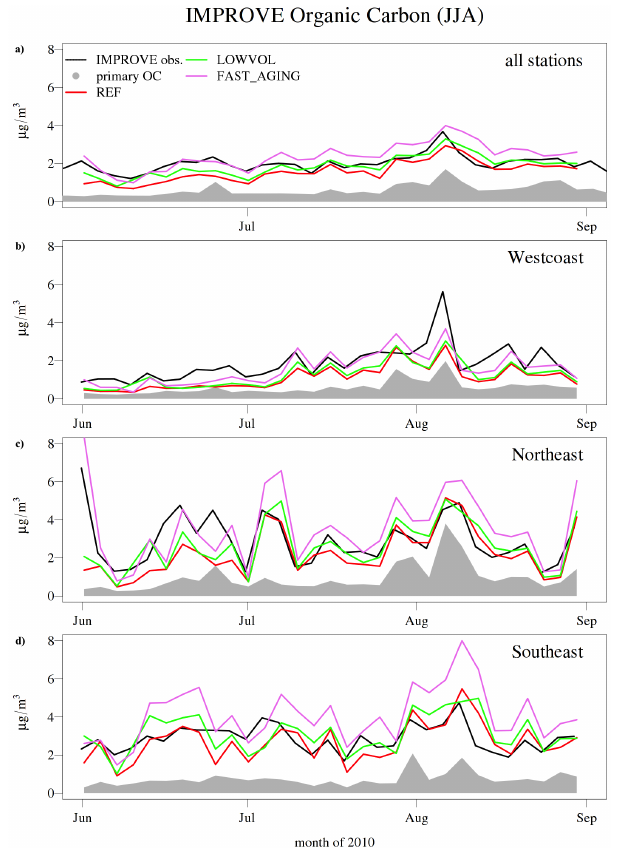
Figure 6. Time lines of ground level total organic carbon (OC) concentrations against IMPROVE measurements like in Fig. 5, but only for the summer period (June, July, and August). Green and pink lines are for LOWVOL and FAST_AGING sensitivity studies, respectively. (a) All stations. (b) West coast: California, Oregon,